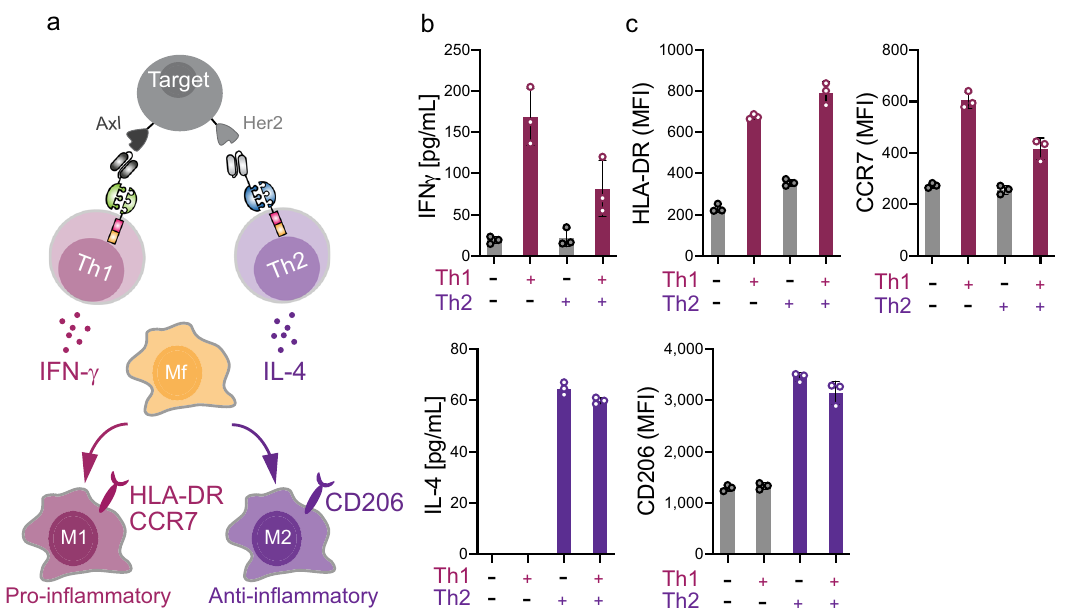
Fig. 2 Engineering endogenous immune system with SUPRA CAR-expressing different T-cell subtypes. a Schematic of controlling macrophage polarization by zipCAR-expressing Th1 and Th2 cells. The RR zipCAR and FOS zipCAR control activity of Th1 and Th2 cells, respectively. α -Axl-EE zipFv binds to RR zipCAR and activates Th1 cells. α -Her2-SYN9 zipFv binds to the FOS zipCAR and activates Th2 cells. Activation of Th1 and Th2 CD4 + T cells leads to secretion of IFN- γ and IL-4, respectively. Macrophage polarizes to M1 (proin fl ammatory) when exposed to IFN- γ secreted by Th1 cell and it polarized to M2 (anti-in fl ammatory) when exposed to IL-4 secreted by Th2 cells. b IFN- γ (Top) and IL-4 (Bottom) production from RR zipCAR- expressing Th1 cells and FOS zipCAR-expressing Th2 cells with or without 5 nM α -Her2-SYN9 zipFv and 5 nM α -Axl-EE zipFv ( n = 3, data are represented as the mean ± SD). c HLA-DR (Top left) and CCR7 (Top right) expression levels in THP-1 macrophages were measured by fl ow cytometer 24 h after staring co-culture. (Bottom) CD206 in THP-1 macrophages was also analyzed at the same time as detecting M2 marker ( n = 3, data are represented as the mean ±